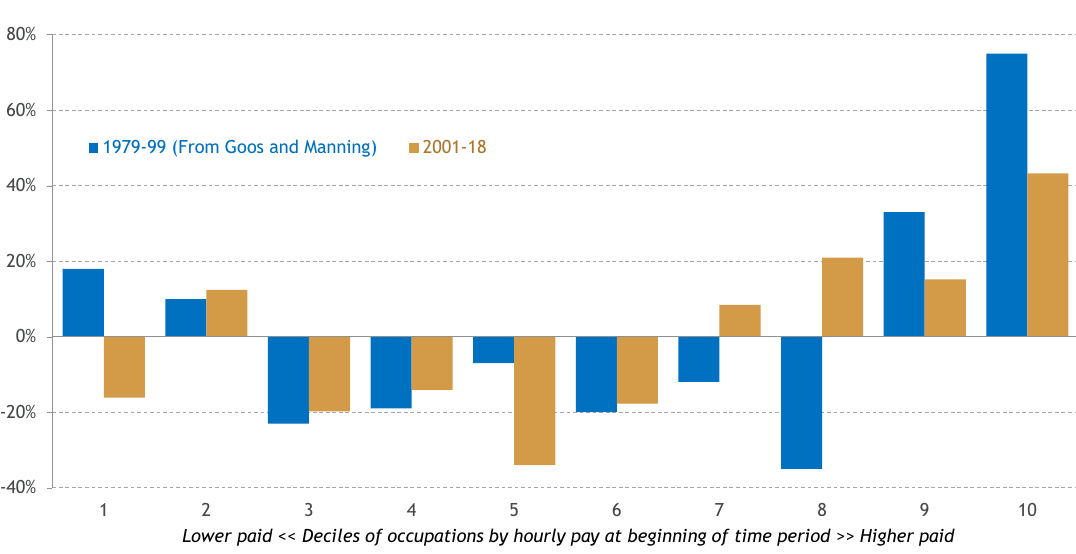
Figure 18: Occupational shifts exhibit an upward ‘U’ shape over the past two decades Percentage change in employment